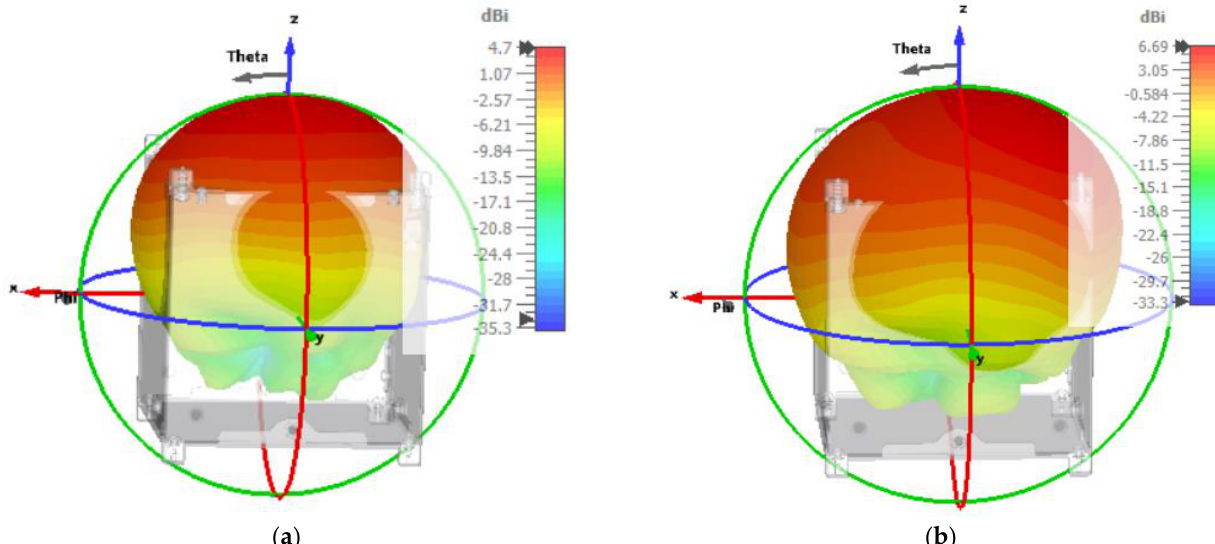
Figure 7. Antenna radiation pattern with 1 U nanosatellite structure at 12.1 GHz ( a ) without AMC metamaterial and ( b ) with metamaterial.